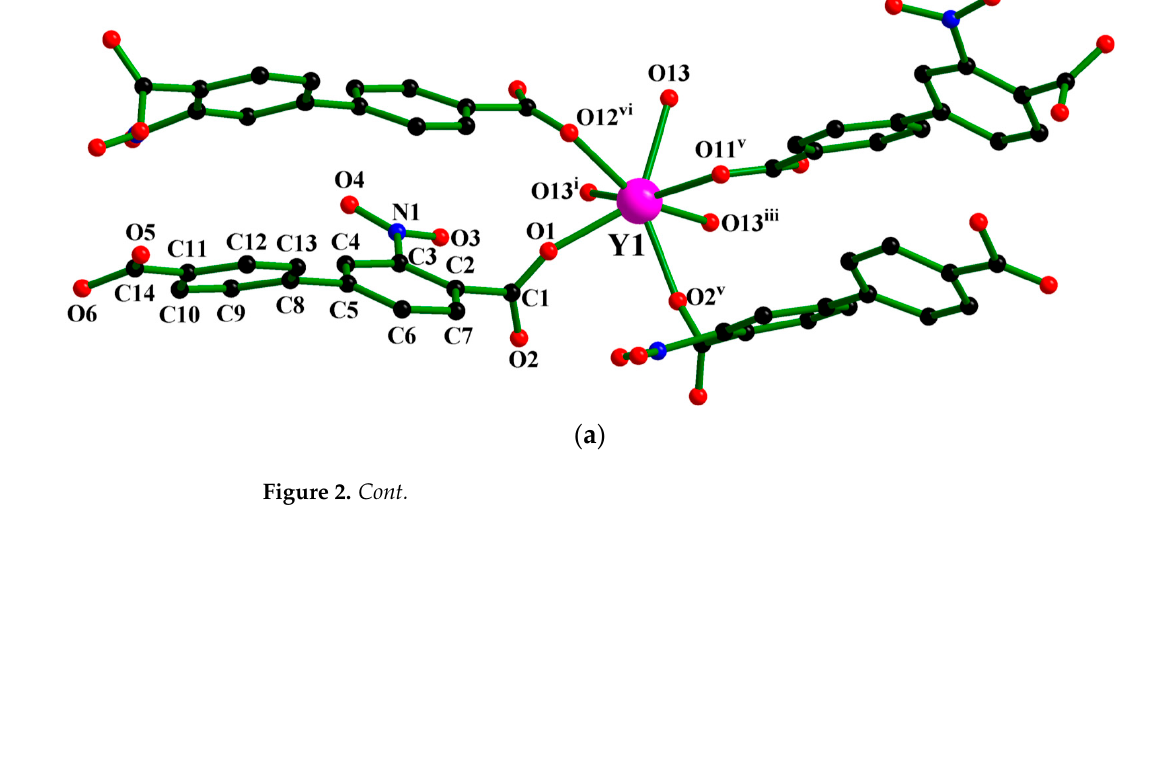
Figure 1. ( a , b ) The coordination mode of two crystallographically independent nba 2 − ligands in 1 .